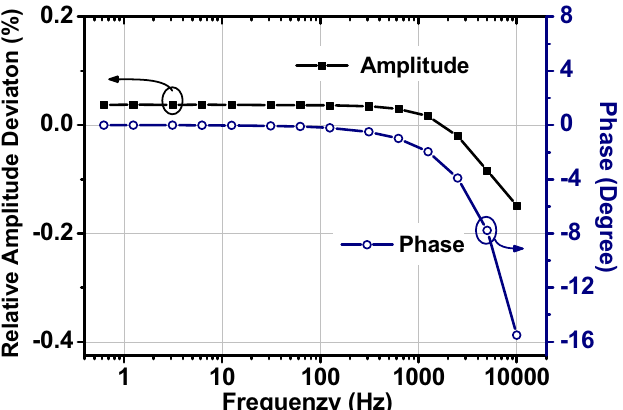
Fig. 15. Example measurement with the PTB dynamic bridge standard of the frequency dependent relative amplitude devi- ation and the phase of a typical strain gauge bridge amplifier in the 2 mV/V measurement